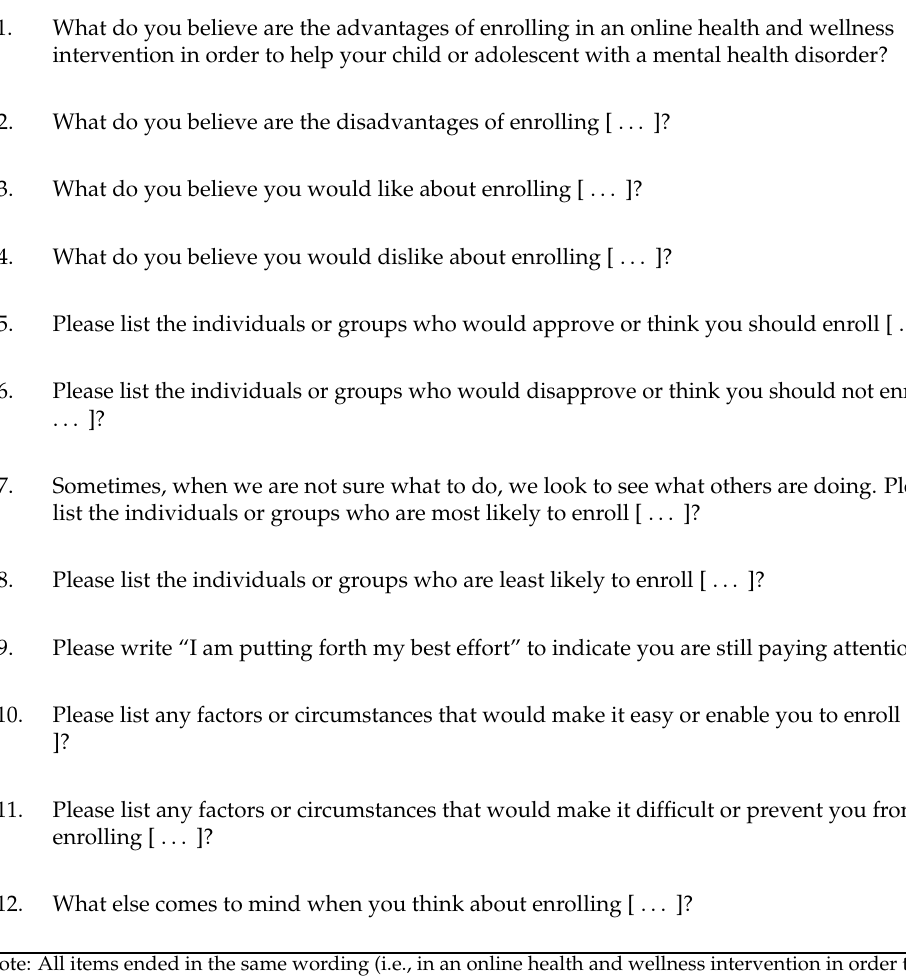
Table 2. Salient Belief Elicitation